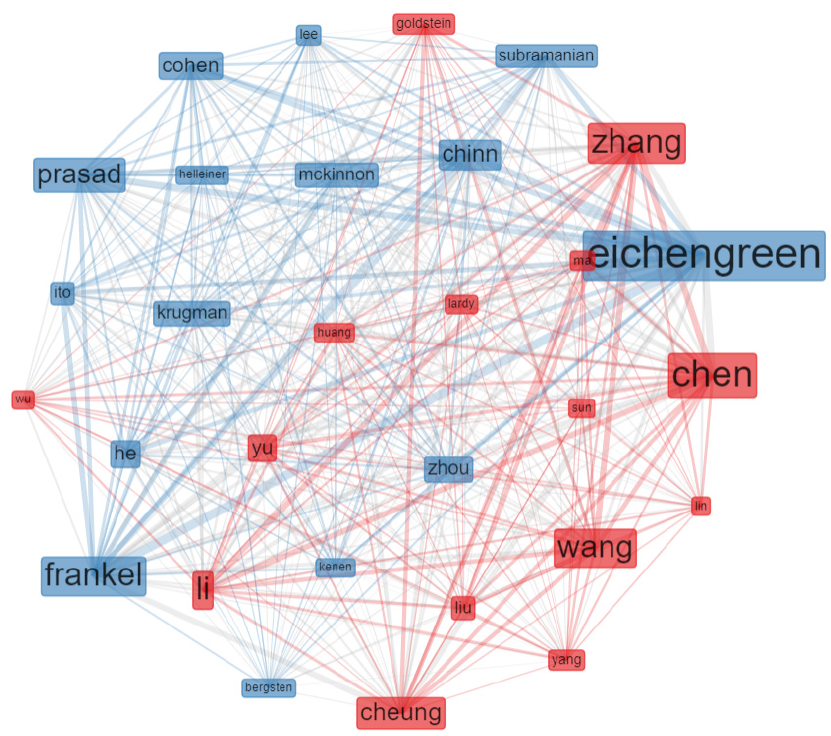
Figure 12. Co-citation network (by authors). Source: Authors’ elaboration using Biblioshiny.